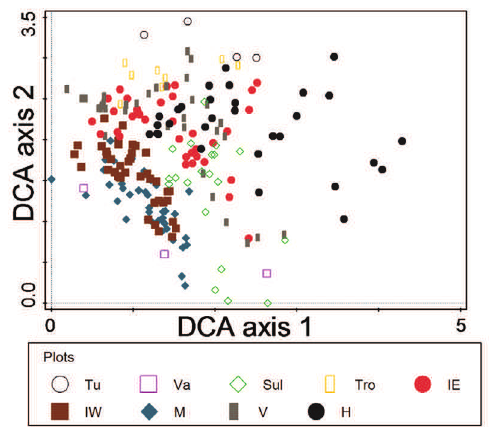
Figure. 1. Positions of the studied plots in relation to DCA axes 1 and 2. Different symbols show in which study area the plots were situated (cf. Table 1). Tu = Tunhovd, Va = Valdresflya, Sul = Suleskard, Tro = Tronfjell, IE = Imingfjell east, IW = Imingfjell west, M = Mår, V = Vågå, H =